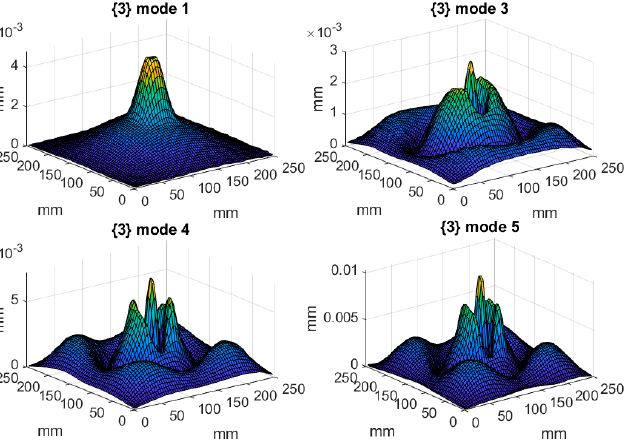
Figure 6. The considered mode shapes for the plate with a debonding between the core and the upper facing.